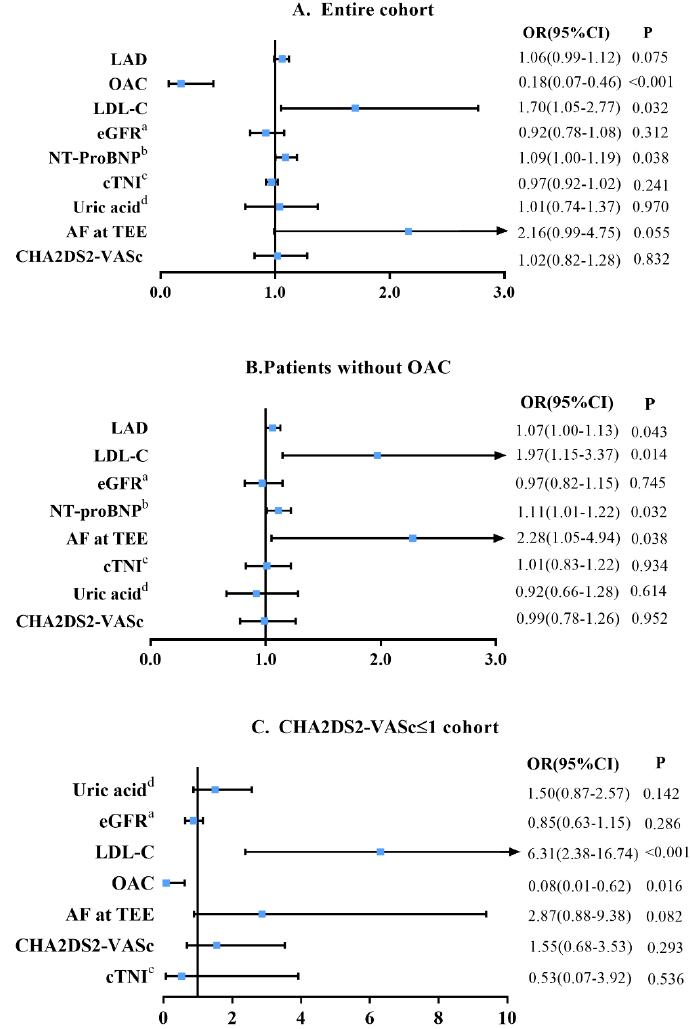
Figure 1. Forest plot for odds ratio in multivariable logistic regressions. ( A ) Entire cohort; ( B ) patients without OAC; ( C ) CHA2DS2-VASc ≤ 1 cohort. a: eGFR (per 10 mL/min/1.73 m 2 increase); b: NT-proBNP (per 500 ng/L increase); c: cTNI (per 100 ng/L increase); d: uric acid (per 100 mmol/L increase). Abbreviations: OAC = oral anticoagulant; eGFR = estimated glomerular filtration rate; LAD = left atrial diameter; NT-proBNP = N-terminal pro-B-type natriuretic peptide; LDL-C = low- density lipoprotein cholesterol; cTNI = cardiac troponin I.